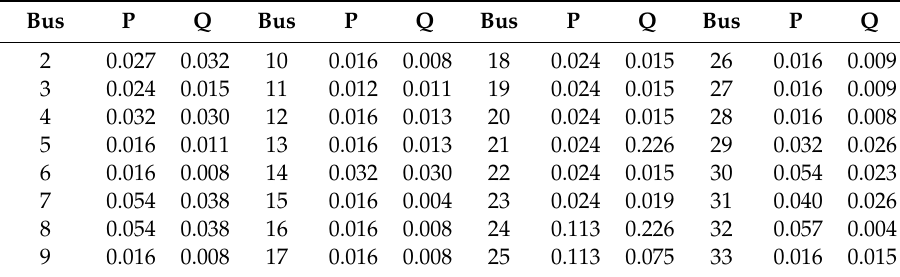
Table 2. Proportion of each bus load in the 33-bus